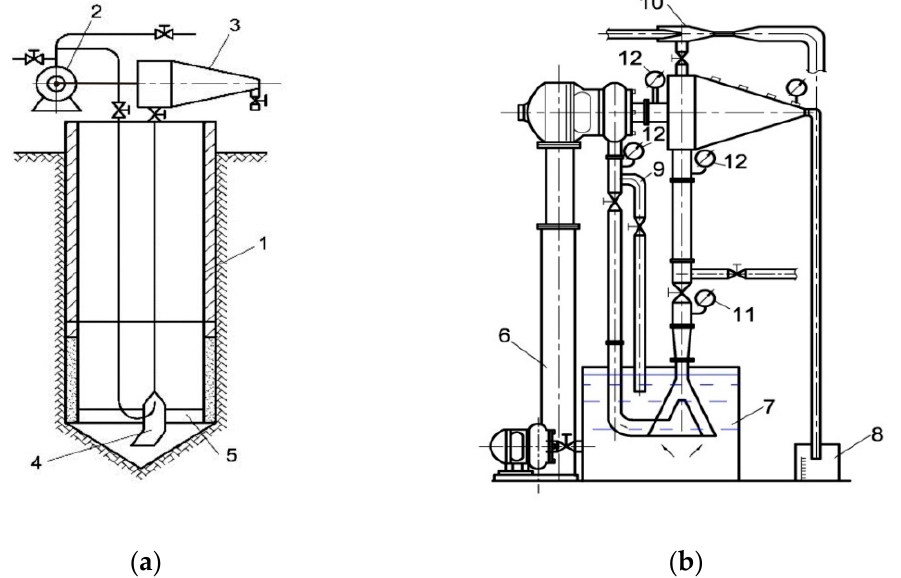
Figure 1. Scheme of the design ( a ) and the stand for the study of the ejector–hydrocyclone installation ( b ). 1—water collector; 2—centrifugal pump; 3—hydrocyclone; 4—ejector; 5—filter; 6—telescopic stand; 7—water intake tank; 8—measuring tank; 9—additional branch; 10—mini